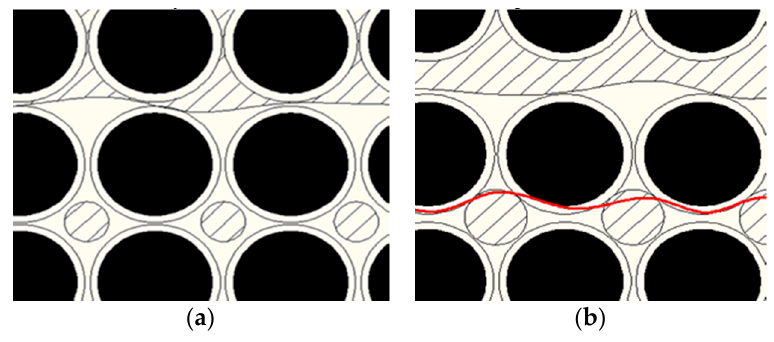
Figure 3. Schematic of freezing soil under a suitable temperature gradient: soil grains, the circles filled with black shadow; ice crystals, the circles or ellipses with slashed shadow; the ice block, the slashed shadow area; the thin unfrozen water film, the annulus outside the filled circle; the curve represents the potential position x sep of the ice lens; and the other symbols represent the unfrozen water. ( a ) Initial state of analysis; and ( b ) the state after some time.